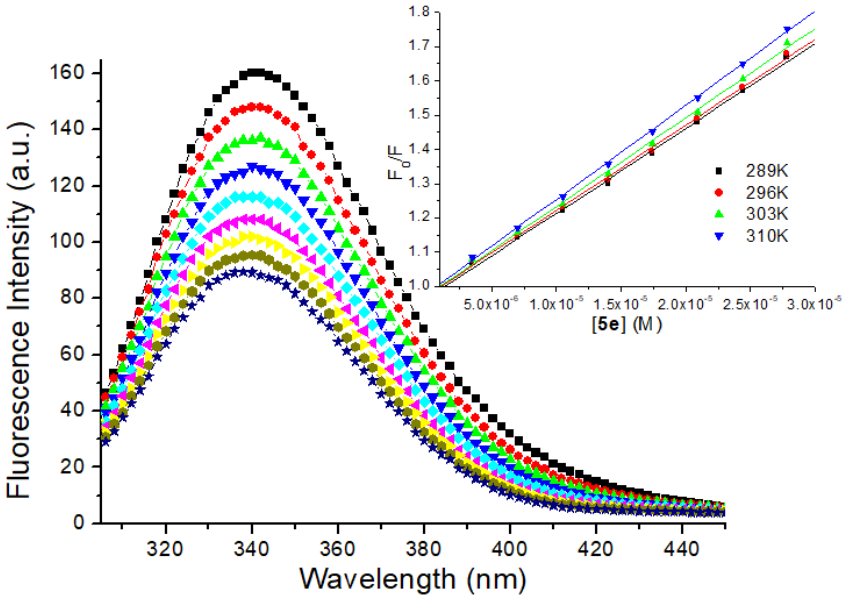
Figure 4. Steady-state fluorescence emission for HSA without and in the presence of successive additions of 5e at 310K and pH = 7.4. [HSA] = 1.00 × 10 − 5 M and [ 5e ] = 0.35; 0.70; 1.05; 1.40; 1.74; 2.09; 2.44; and 2.78 × 10 − 5 M.